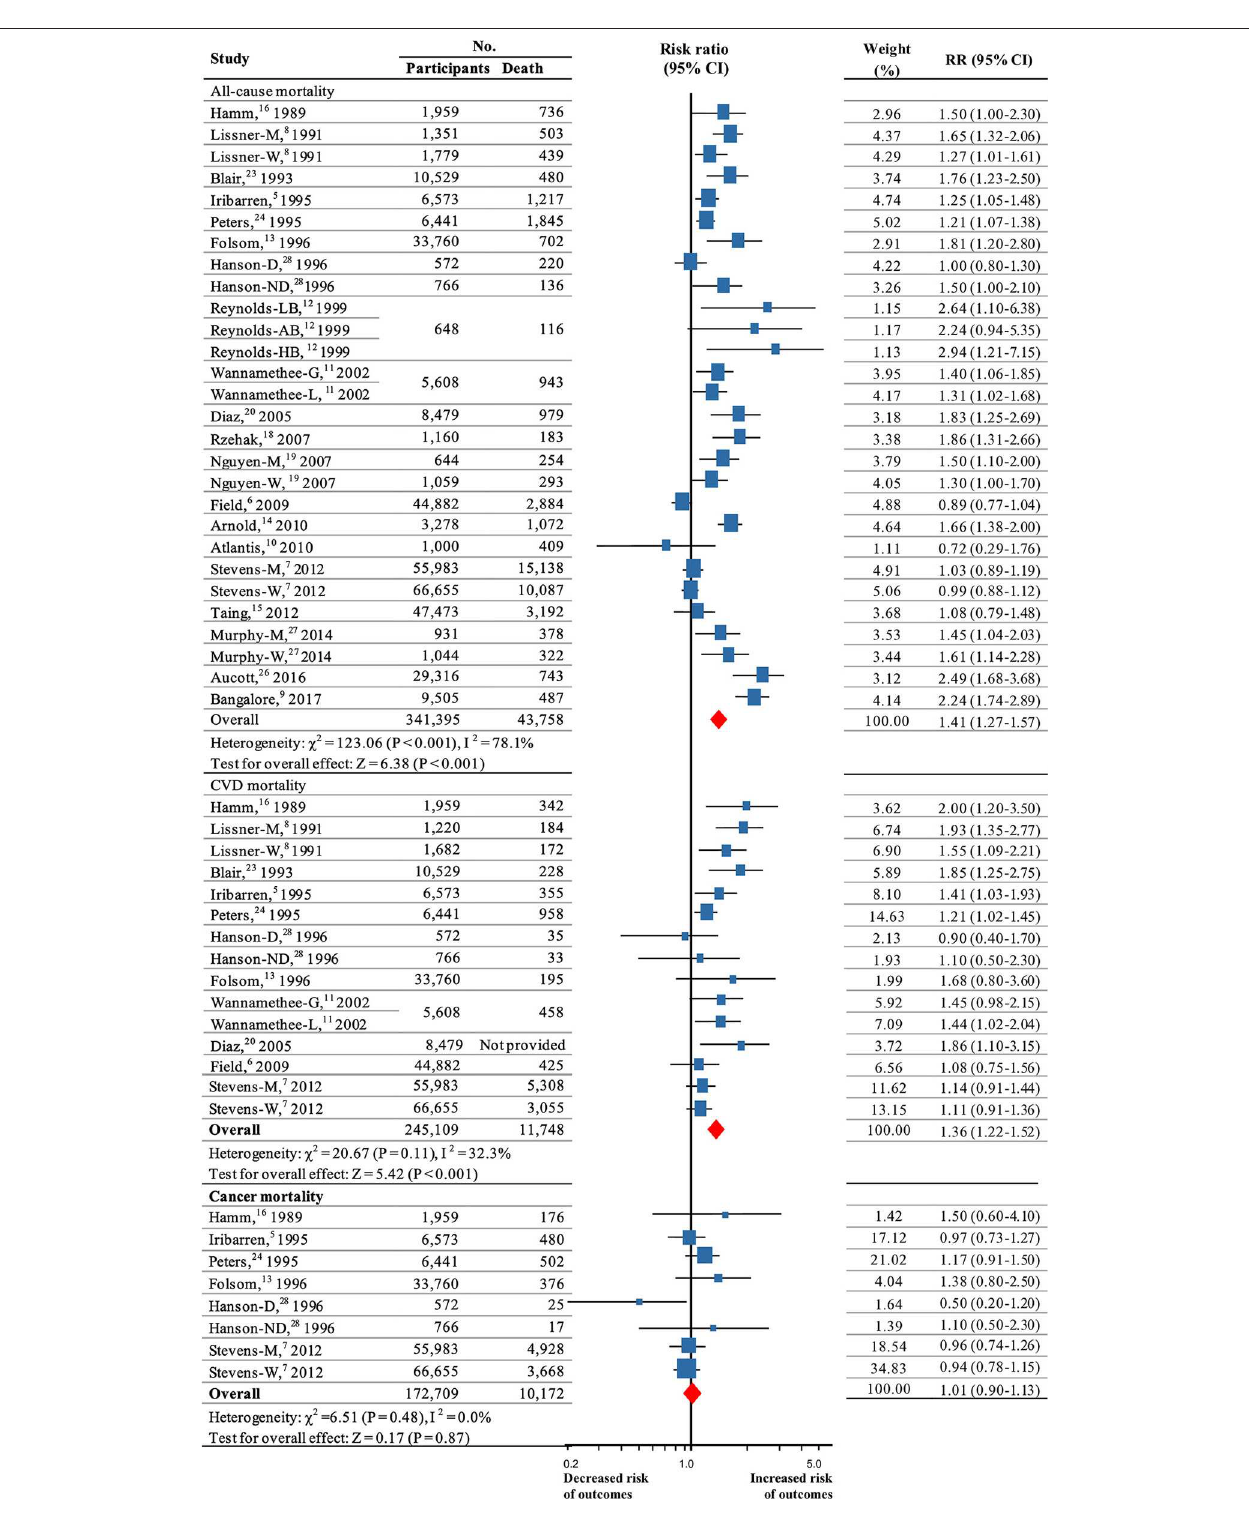
FIGURE 2 | Summary RRs for the association between weight fluctuation and risk all-cause mortality, CVD mortality and cancer mortality. RR and 95% CIs were calculated using the random-effects model used to pool data. Error bars indicate 95% CIs. Risk ratio data are rounded to 2 decimal places; error bars reflect unrounded values. RR, relative risks; CI, confidence interval; CVD, cardiovascular disease. M, men; W, women; G, weight cycle ending with gain; L, weight cycle ending with loss; D, weight fluctuations in diabetes; ND, weight fluctuations in non-diabetes; LB, weight cycle in low BMI population; AB, weight cycle in average BMI population; HB, weight cycle in high BMI